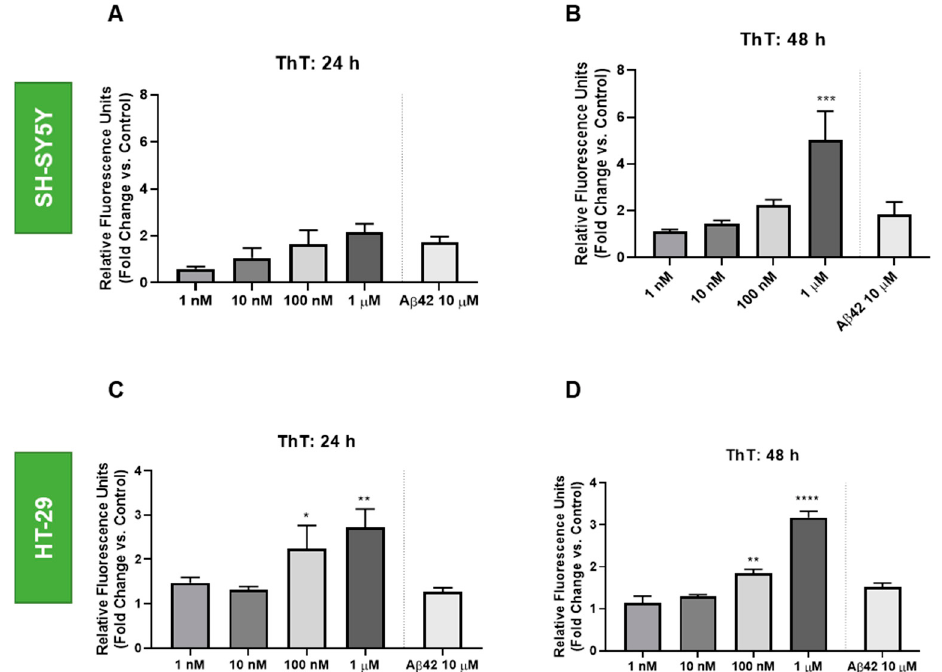
Figure 8. Effects of treatment with DOXO on the formation of aggregates in SH-SY5Y neuroblastoma cells ( A , B ) and HT-29 colon cancer cells ( C , D ) for 24 h (left) and 48 h (right) treatments. Cells were stained with ThT and aggregate formation was quantified in relative fluorescence units. Cells were treated with increasing concentrations of DOXO. A β 42 peptide was added as a positive control. The results are shown as a fold change vs. the control and are expressed as the mean ± SEM of three independent experiments ( n = 3). * Statistically significant vs. the control at p < 0.05. ** Statistically significant vs. the control at p < 0.01. *** Statistically significant vs. the control at p < 0.001. **** Statistically significant vs. the control at p <